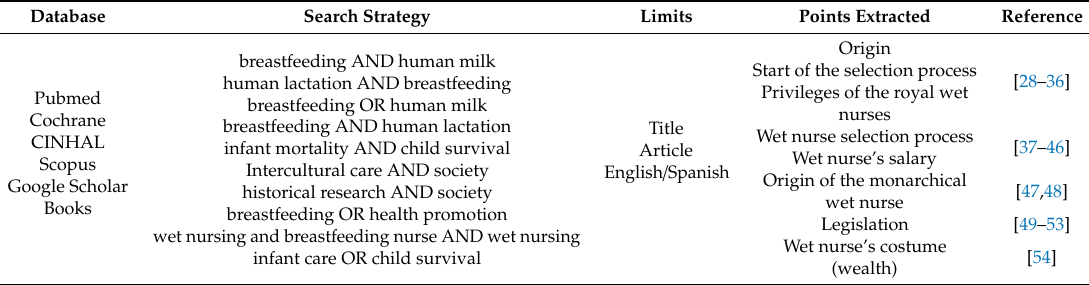
Table 2. Thematics blocks related to the